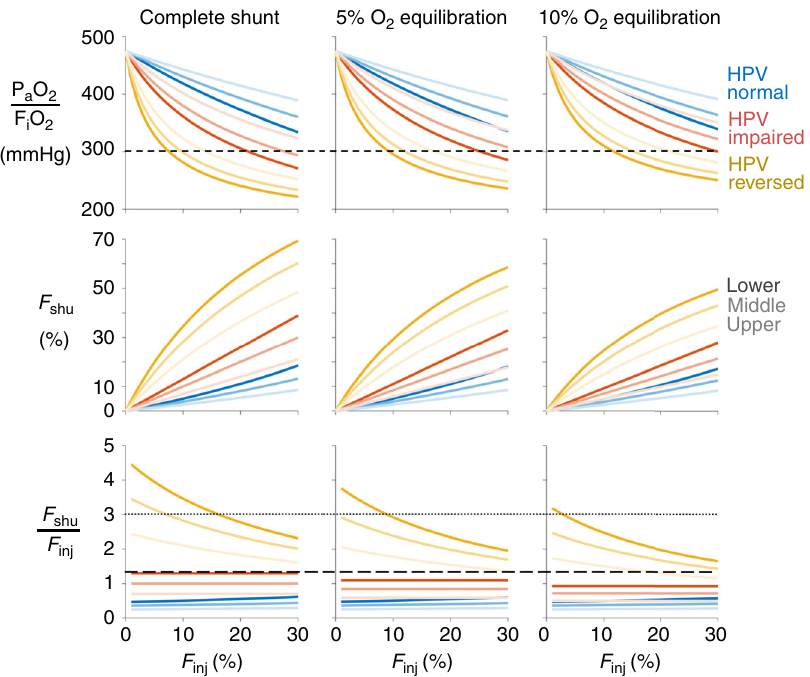
Fig. 2 Effects of alterations to hypoxic pulmonary vasoconstriction (HPV). Severity of pulmonary shunt with respect to fractional injury extent ( F inj ), type of HPV modi fi cation (blue: normal; red: impaired; yellow: reversed), injury location within one height level (light to dark color). Rows correspond to the ratio of arterial oxygen tension to inspired oxygen fraction ( P a O 2 : F i O 2 ), shunt fraction (F shu ), and ratio of shunt fraction to injured fraction ( F shu : F inj ). Columns correspond to varying degrees of impaired oxygen equilibration between capillary blood and alveolar gas in the injured region. Baseline perfusion gradient was 30%, and reversed HPV was modeled with 72% reduction of vascular resistance in injured regions. Short-dashed line in the top row indicates P a O 2 : F = 300 mmHg, a threshold for ARDS. Dotted and long-dashed lines in the bottom row indicate F i O 2 reported for COVID-19 and ARDS patients, respectively 1